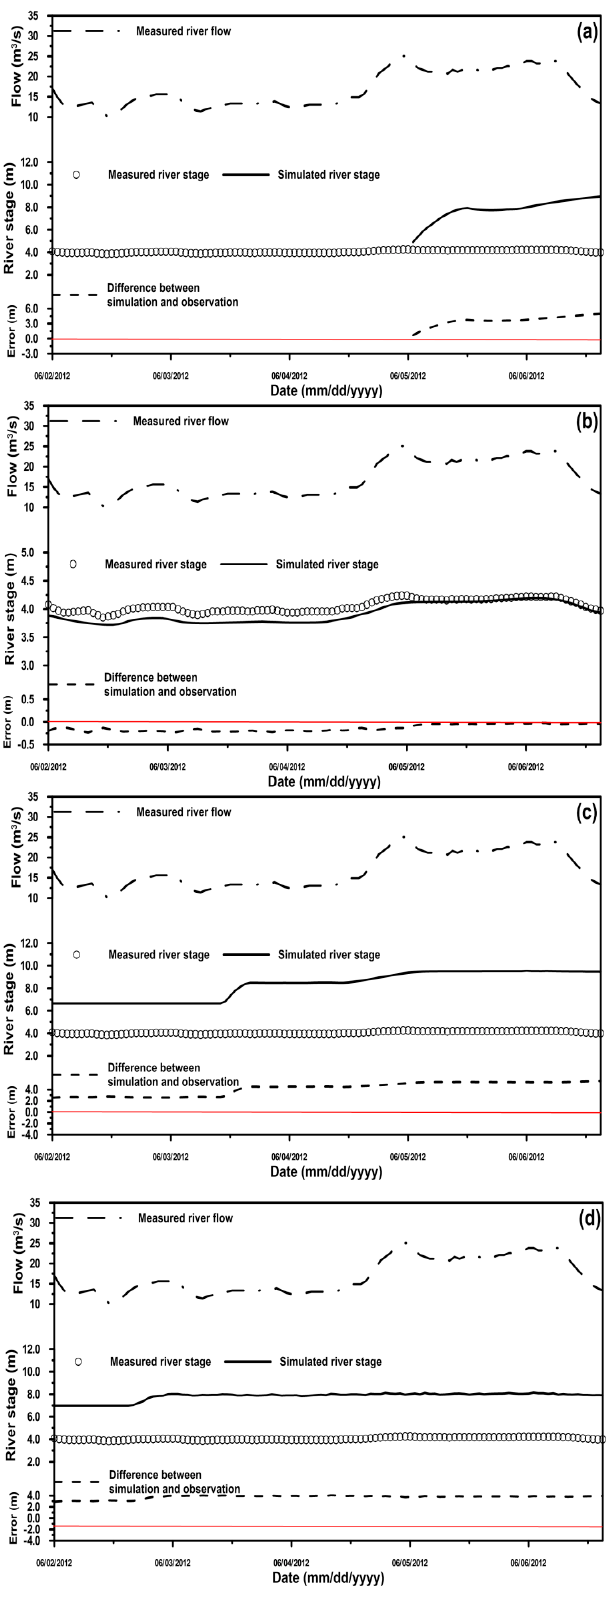
Figure 8. A comparison of the simulated and observed river stages at the Xinzhong station under low flow conditions using the 2D model with the: ( a ) original cross-section data; and resampled cross-section data according to: ( b ) the linear interpolation method; ( c ) the IDW method, and ( d ) the NN method.